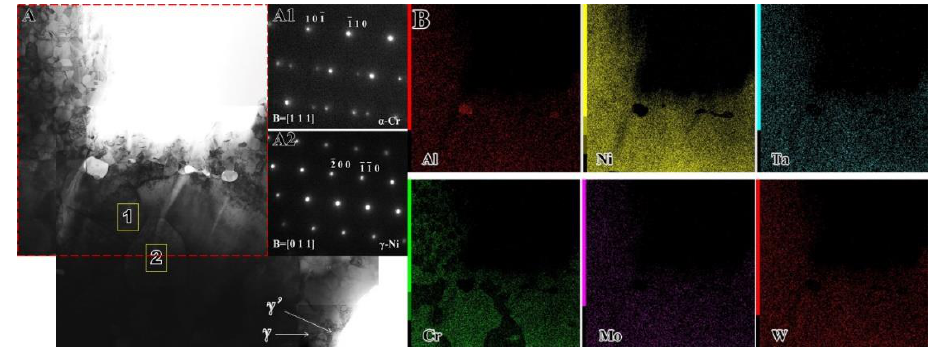
Figure 10. TEM bright field image ( A ) and elemental maps ( B ) displayed the microstructure of the interface between SN-N5 coating/substrate after oxidation at 1050 °C in air for 100 h. ( A1 , A2 ) were the SAED patterns obtained at the area denoted as 1 and 2 in ( A ).